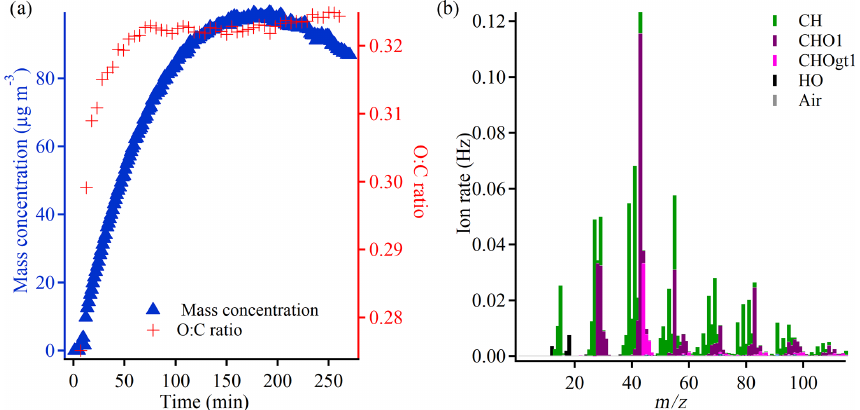
Figure 1. (a) Evolution of the SOA mass (density corrected) and the O : C ratio during a typical experiment (50ppb α -pinene, − 15 ◦ C, experiment 2.3) and (b) the mass spectra of the experiment obtained at the mass peak (5min average). gt denotes greater than.